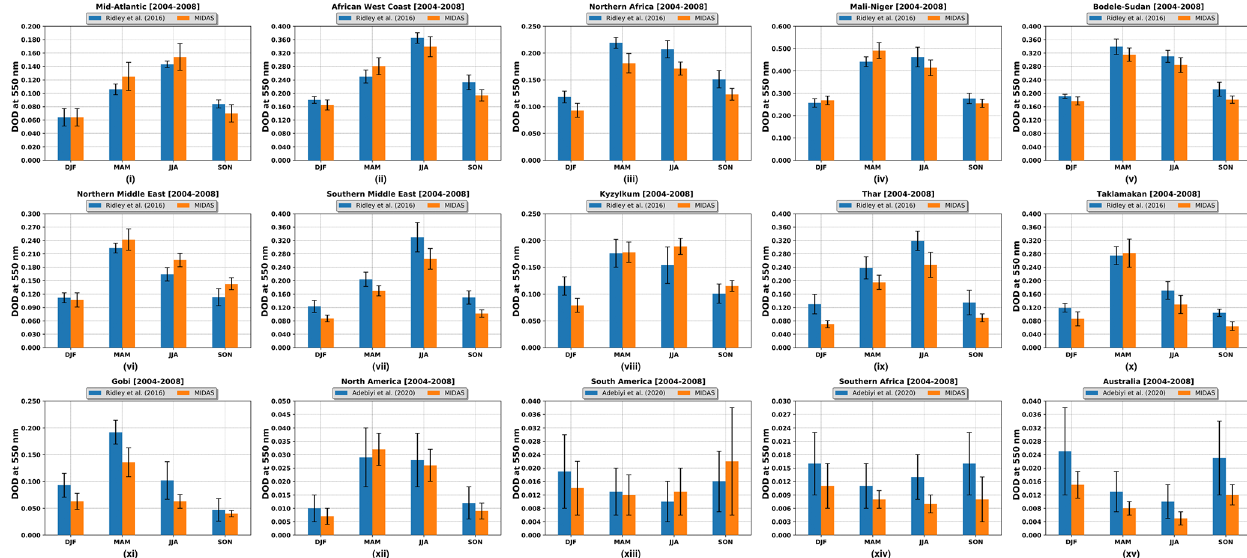
Figure 12. Seasonal DODs, representative for the period 2004–2008, based on the MIDAS dataset (orange bars), Ridley et al. (2016) (blue bars) and Adebiyi et al. (2020) (blue bars), for 15 regions (their names are given at the top of each plot) defined in Kok et al. (2021a) (see Table 2). The error bars represent the estimated uncertainties. From (i) to (xi) , the blue bars correspond to the Ridley et al. (2016) results, whereas for the remaining regions MIDAS DODs are compared against the corresponding levels obtained by Adebiyi et al.